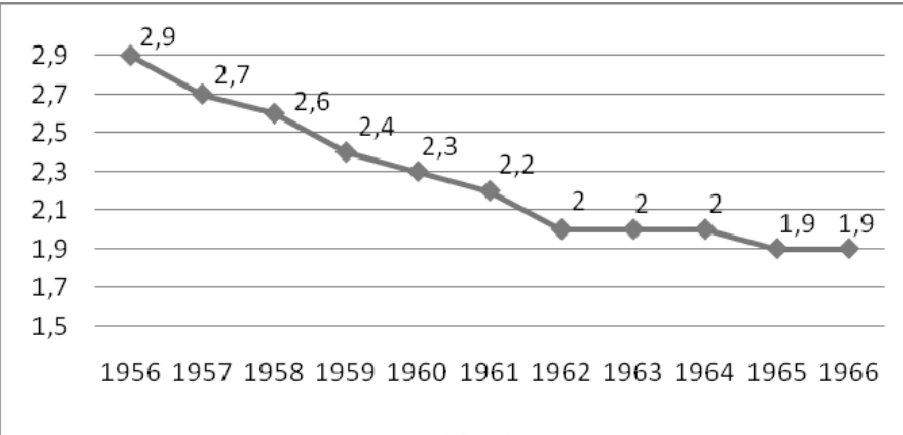
Figure 1. Total fertility rate (TFR) in Romania, 1956-1966